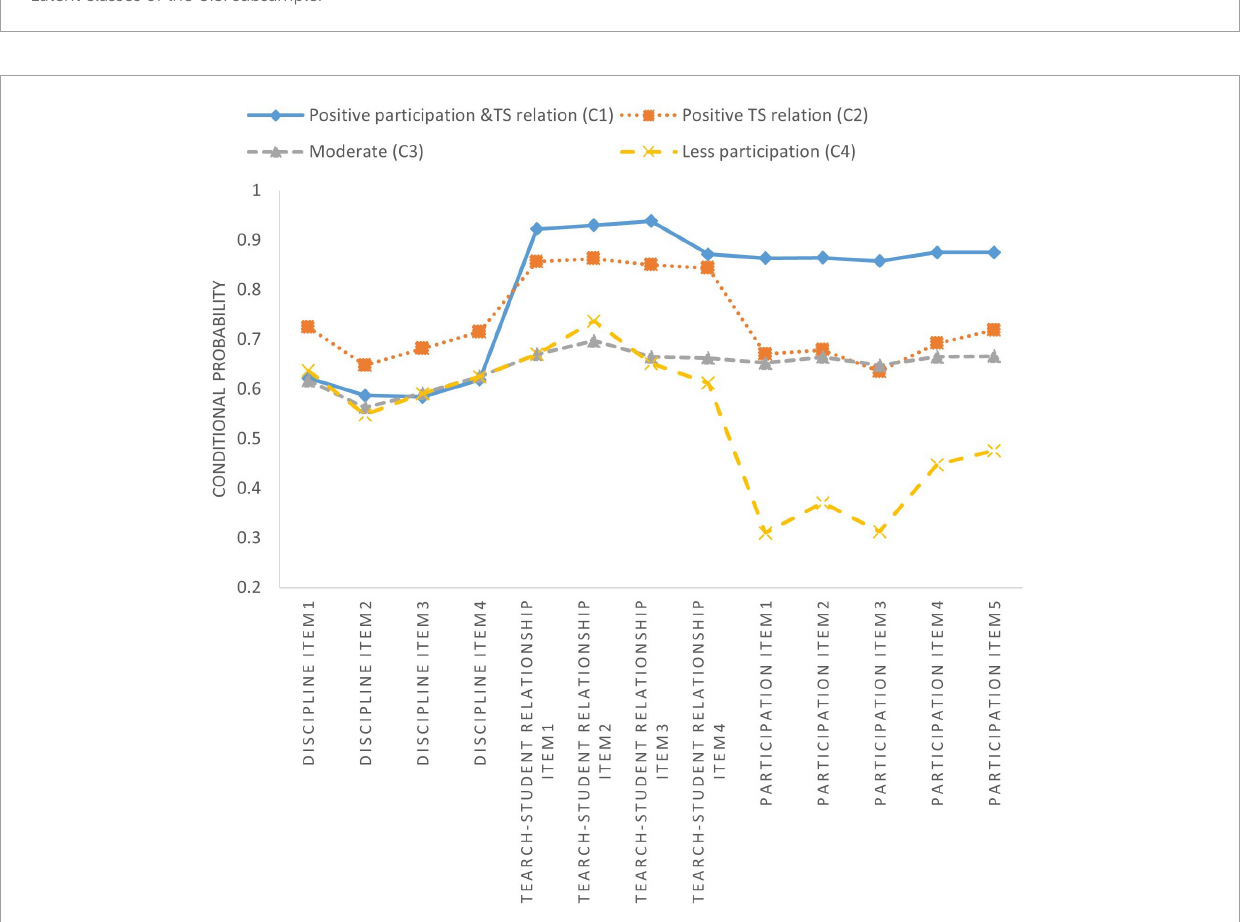
FIGURE1 Latent classes of the U.S. subsample.